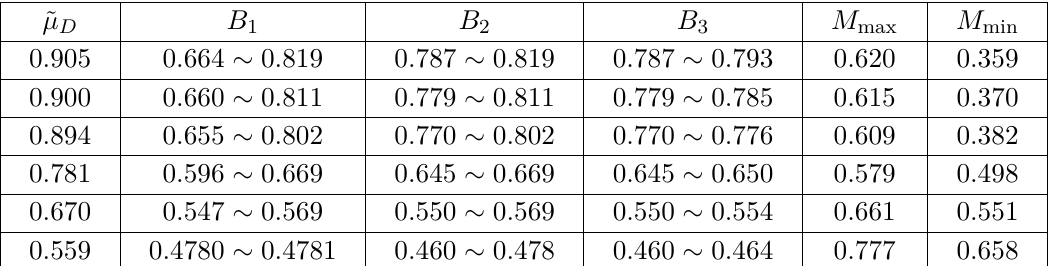
Table 2. Maximum and minimum ADM masses ( M max and M min ) of the DBSs, and the existence domain of the synchronized frequency ˜ ω for several values of the Dirac field mass ˜ µ D . B 1 , B 2 and B 3 represent the first, second and third branches of the orange line in figure 4, respectively. All solutions have ˜ µ S = 1 .